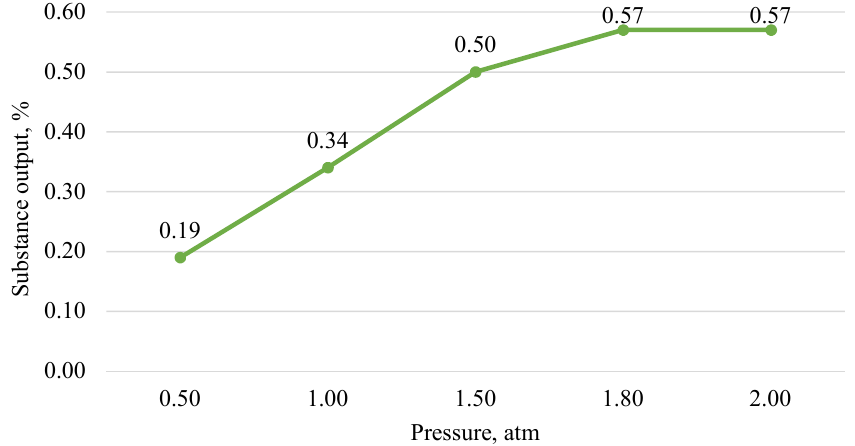
Fig. 5. Photo and Scheme of the barothermal installation: 1 – water level indicator; 2 – steam generator; 3 – steam generator pressure indicator; 4 – steam admission valve to the reactor; 5 – bottom release valve; 6 – steam distributor; 7 – reactor; 8 – container; 9 – reactor pressure indicator; 10 – top outlet valve; 11 – water cooler; 12 – reverse water cooler